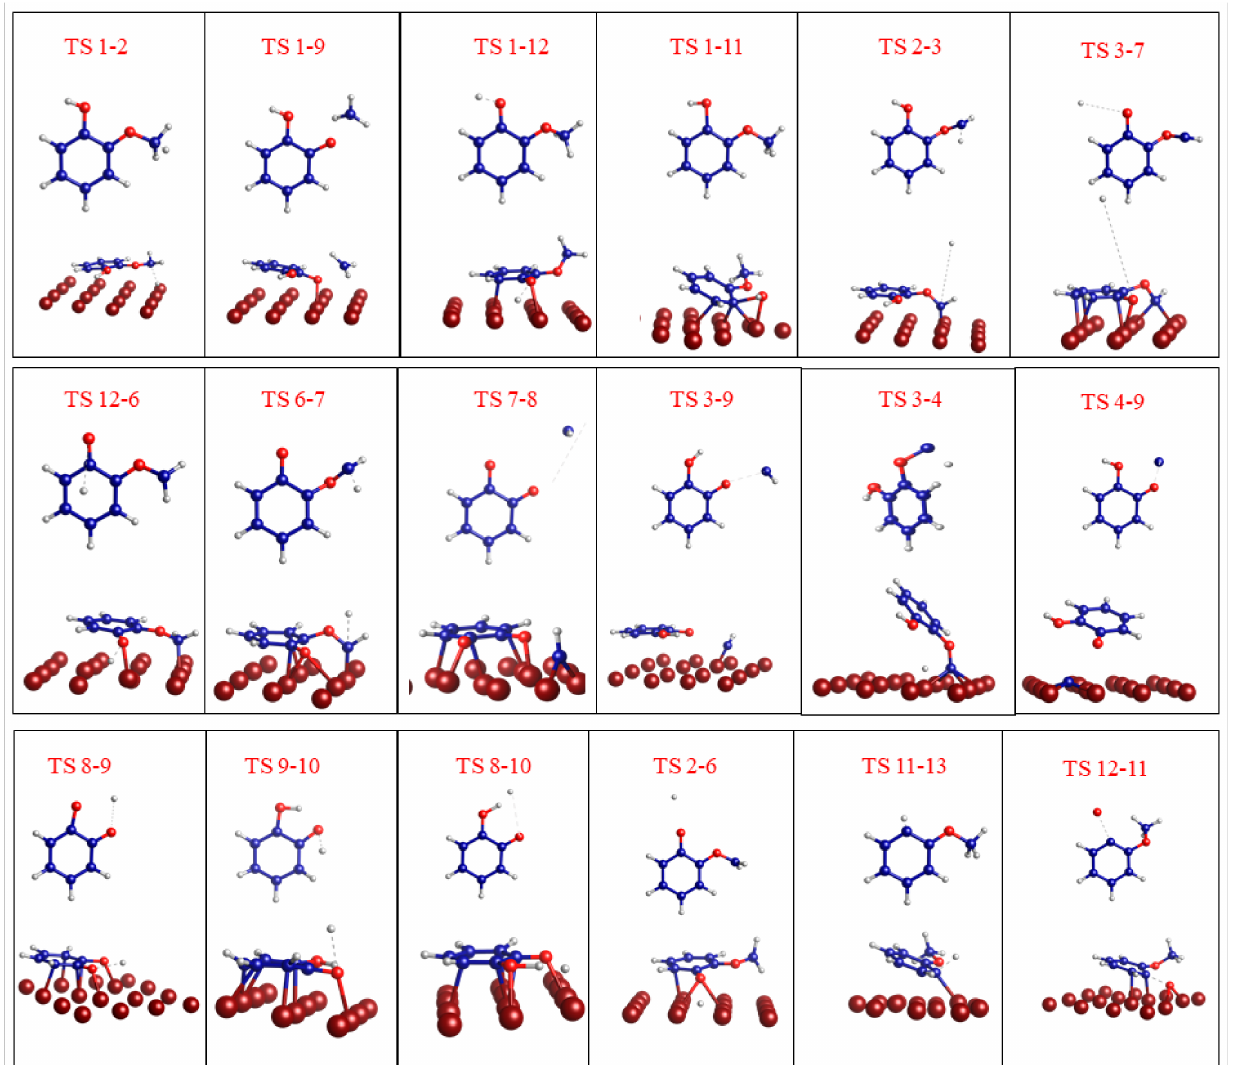
Figure 4. Top and side views of the geometries of the various transition state structures involved in the HDO reaction of guaiacol on Cu (111). Cu: brown; O: red; C: blue; H: white. The top views are transition state structures shown without the Cu (111) surface atoms. The side views are the transition state structures shown with the Cu (111) interacting surface atoms. The broken lines indicate the bonds being formed and